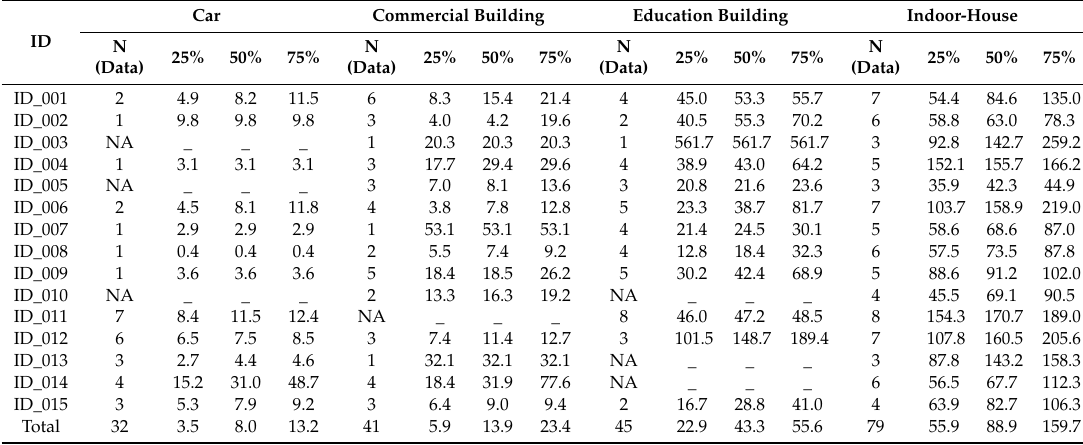
Table 4. Percentiles of daily accumulated PM2.5 exposure amount ( µ g) per activity and per